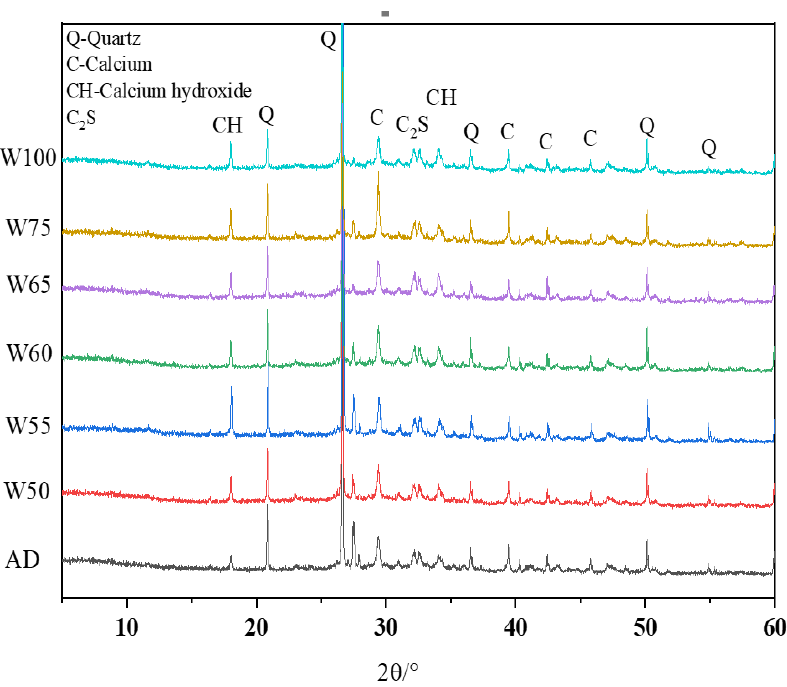
Figure 17. XRD spectra of the interfacial transition zone of recycled concrete.